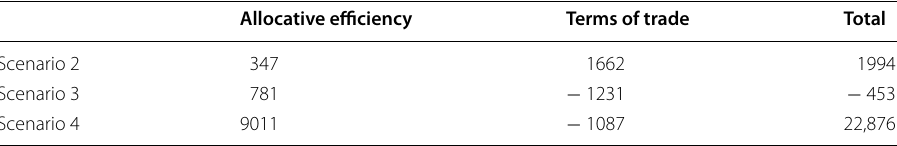
Table 8 Welfare impact on Canada in million USD (with USA as a TPP member)